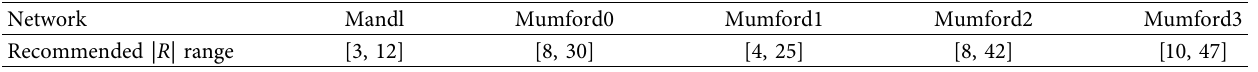
Table 12: Recommended | R |